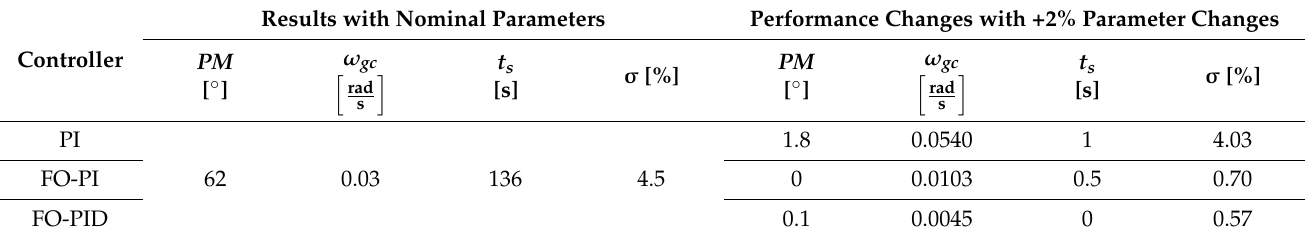
Table 4. Performance results for +2% parameter changes in the process.